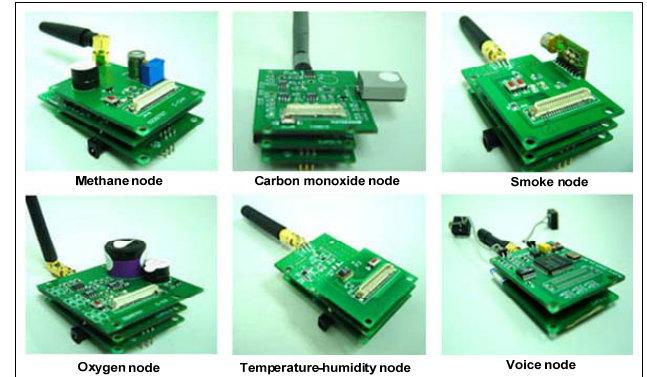
Figure 4. Circuit boards of Cicada sensor nodes.